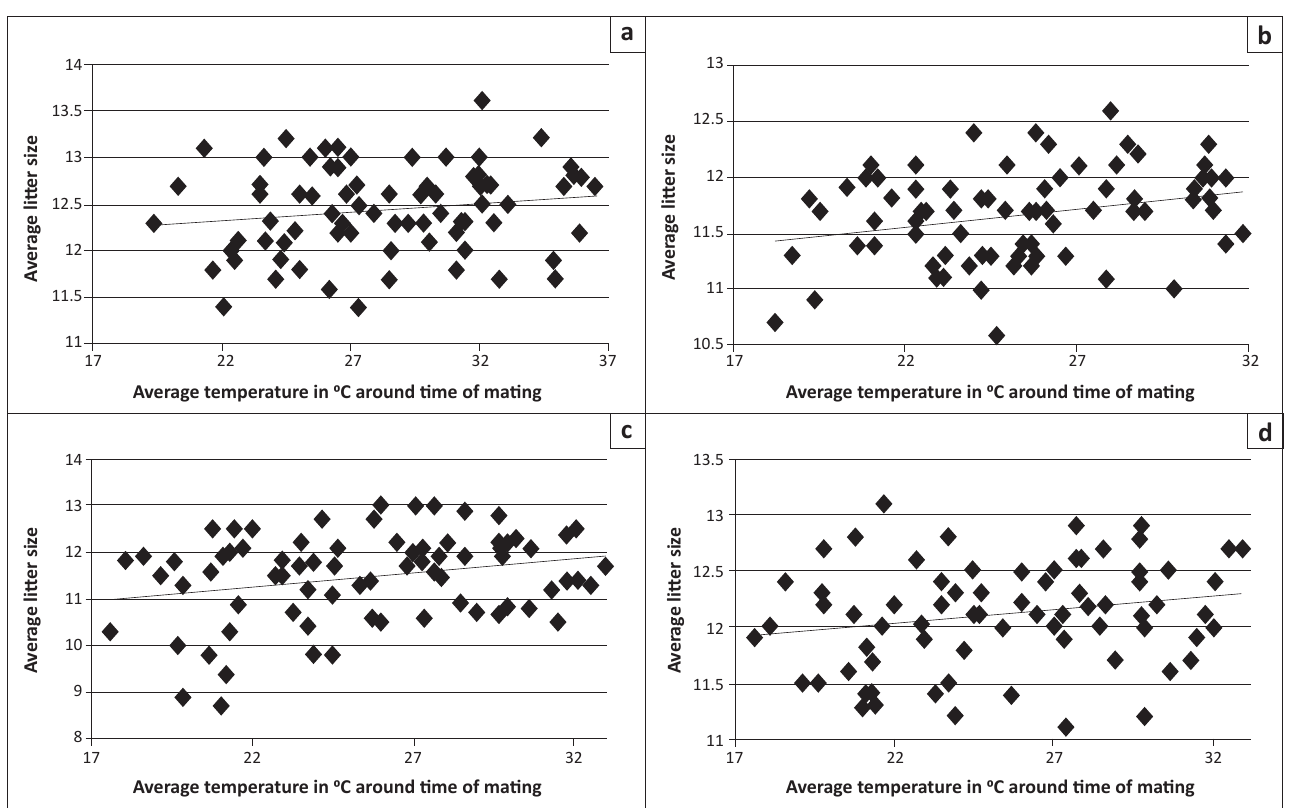
FIGURE 3: The effect of various temperatures around the time of farrowing on litter size. (a) Breeding unit 1, (b) breeding unit 2, (c) breeding unit 3 and (d) breeding unit 4.